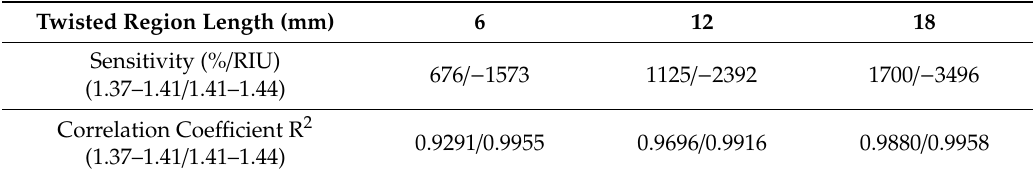
Figure 7. The effect of twisted region length on the RI sensing performances for the sensors with active fiber diameter of 100 μ m, and passive fiber diameters of 100, 200, and 300 μ m. Table 4. The sensitivity results from Figure 7.